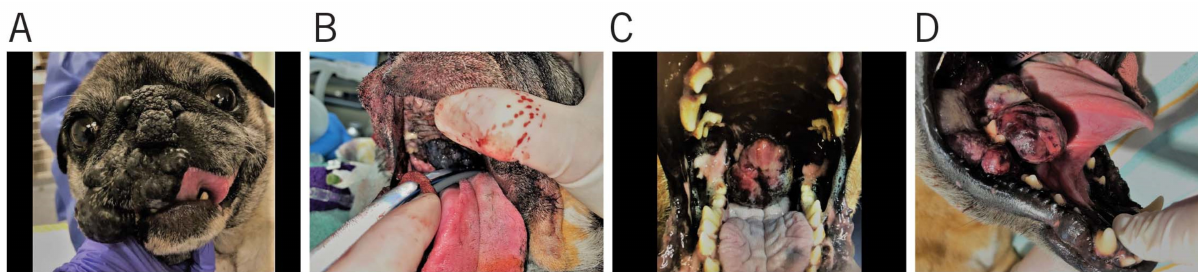
Figure 1. Similar clinical presentation of histologically confirmed histologically well-differentiated melanocytic neoplasm (HWDMN) and oral malignant melanoma (OMM): ( A ) Right rostral muzzle and nasal planum pigmented HDWMN obliterating normal anatomy; ( B ) Pigmented HWDMN of the hard palate extending into the soft palate; ( C ) Variably pigmented proliferative OMM of the soft palate; ( D ) Variably pigmented proliferative OMM of the right caudal